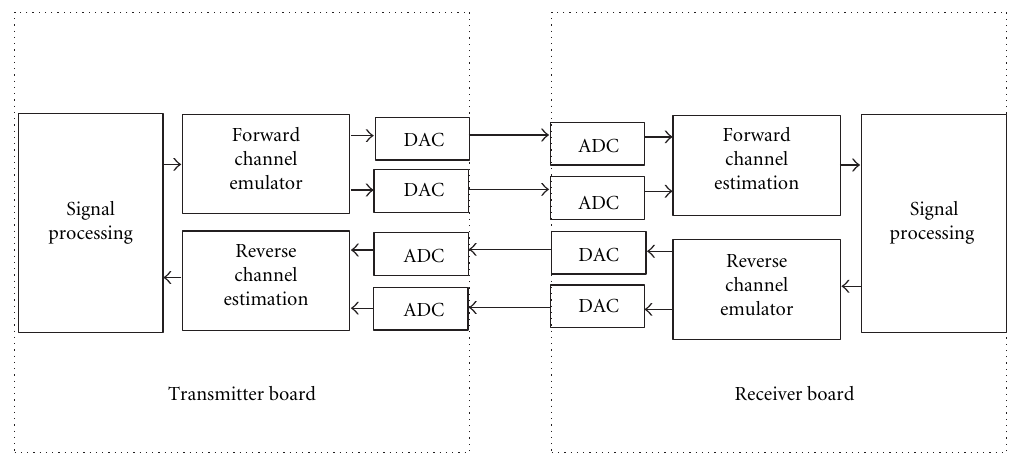
Figure 4: System diagrams of transmitter and